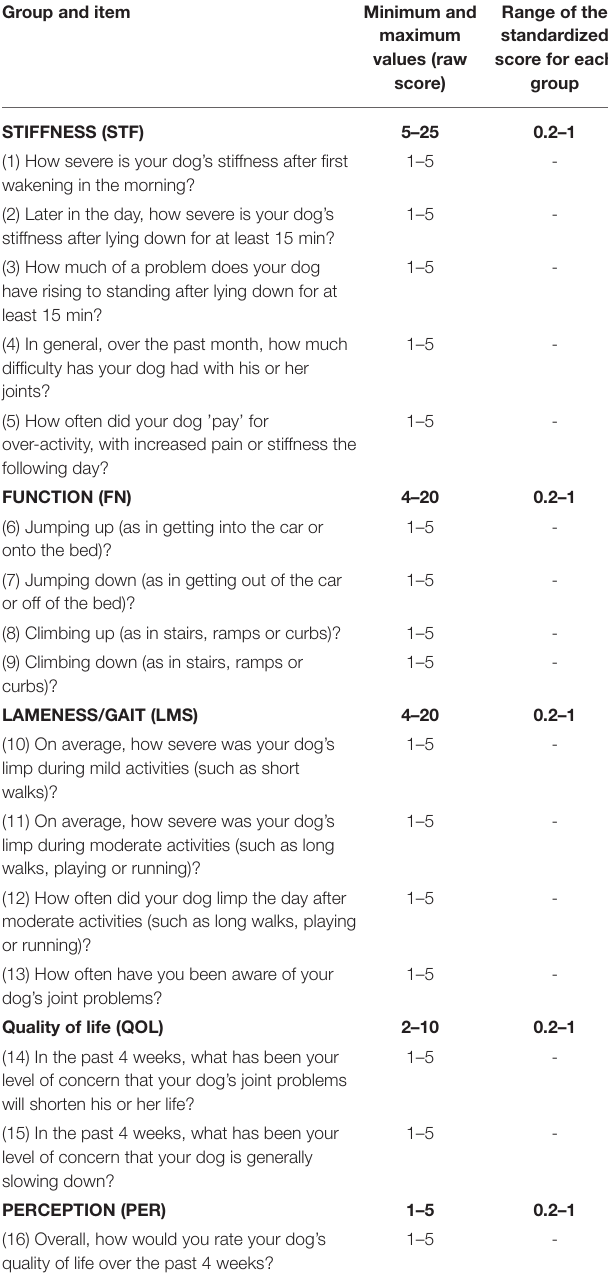
TABLE 2 | Part C in the questionnaire based on the validated ACVS COI, modified and validated in Swedish after translation. Group and